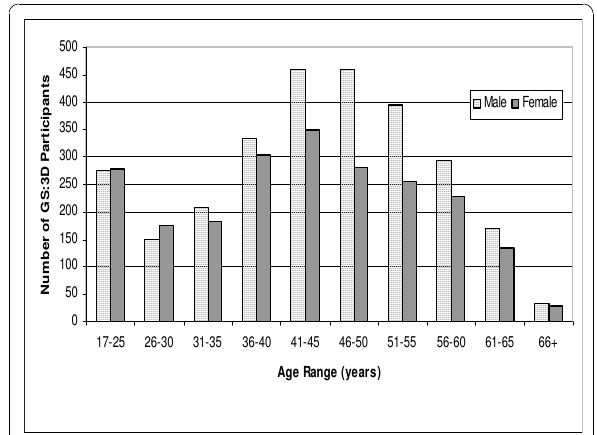
Figure 4 Age Range and Sex of GS:3D participants . Chart showing age range and sex of GS:3D participants. Males are represented by pale bars and females by dark